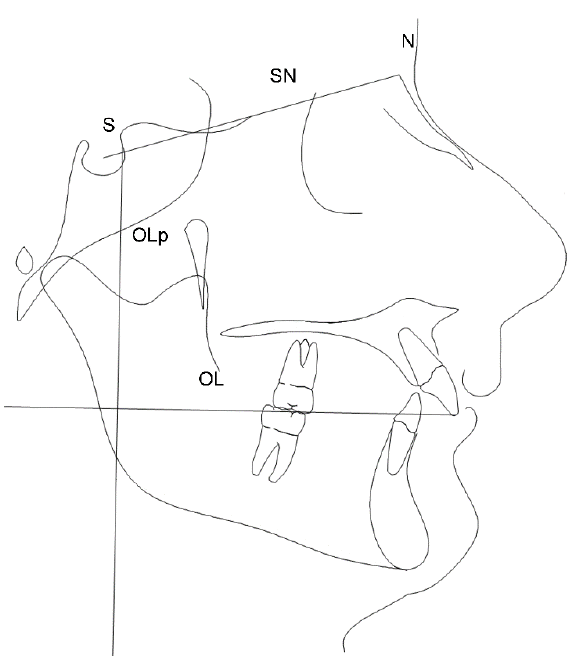
Figure 1. Cephalometric reference lines.